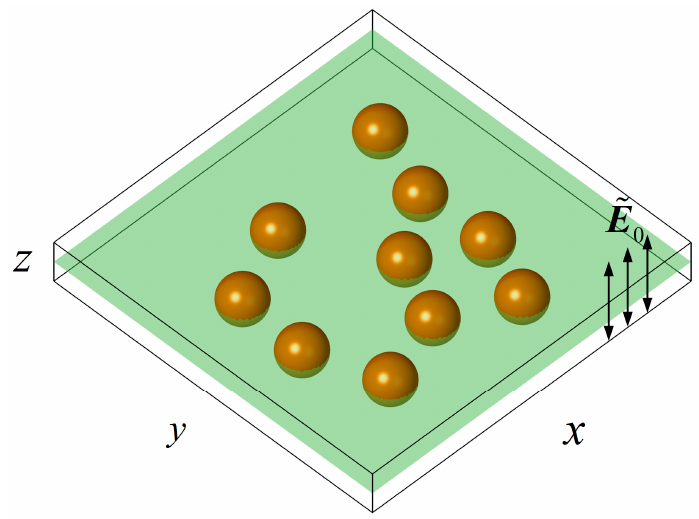
Figure 1. A number of particles randomly suspended on a flat chip filled with electrolyte and a uniform alternating current (AC) electric field (cid:101) E 0 is applied perpendicular to the chip